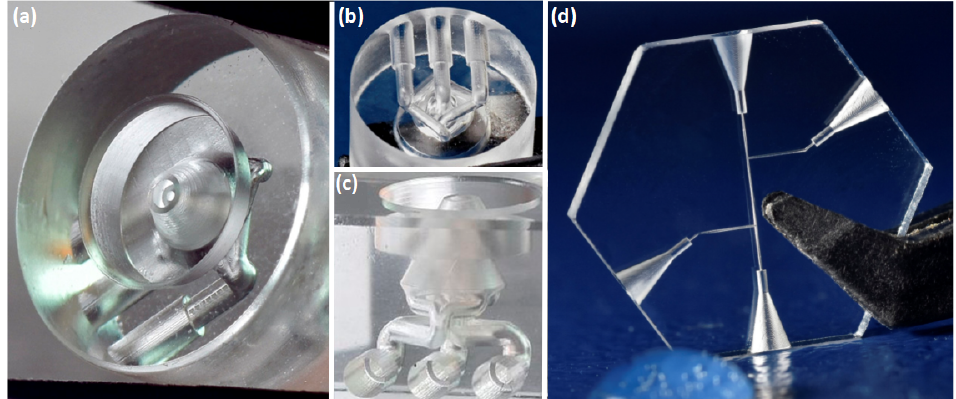
Figure 7. Example of microfluidic devices. ( a – c ) nozzle for biological applications, ( d ) glass connector for capillary electrophoresis, diameter 15 mm, thickness 2 mm [154].